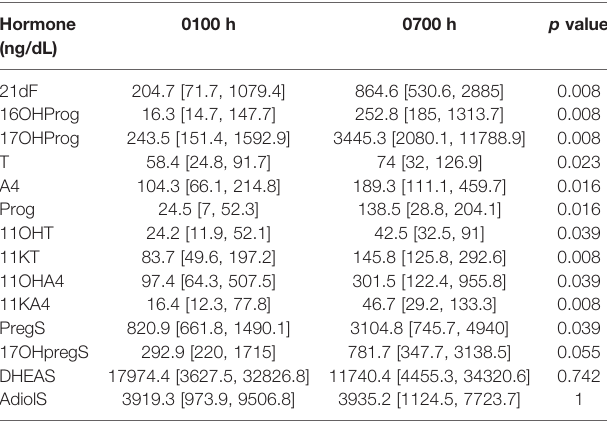
TABLE 1 | Comparison of steroid concentrations between 0700h and 0100h during oral glucocorticoid treatment. Hormone (ng/dL)